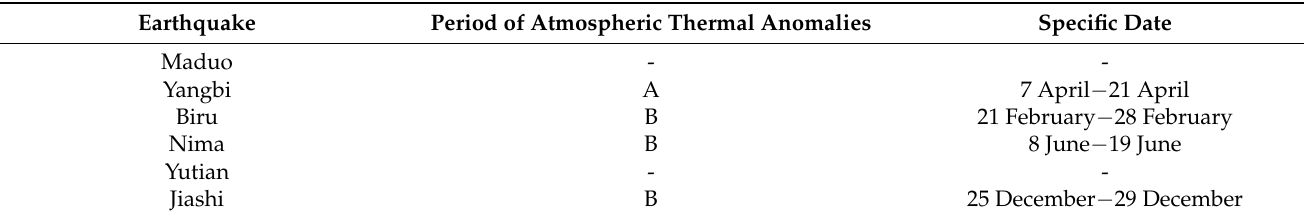
Table 4. The periods and specific date of atmospheric thermal